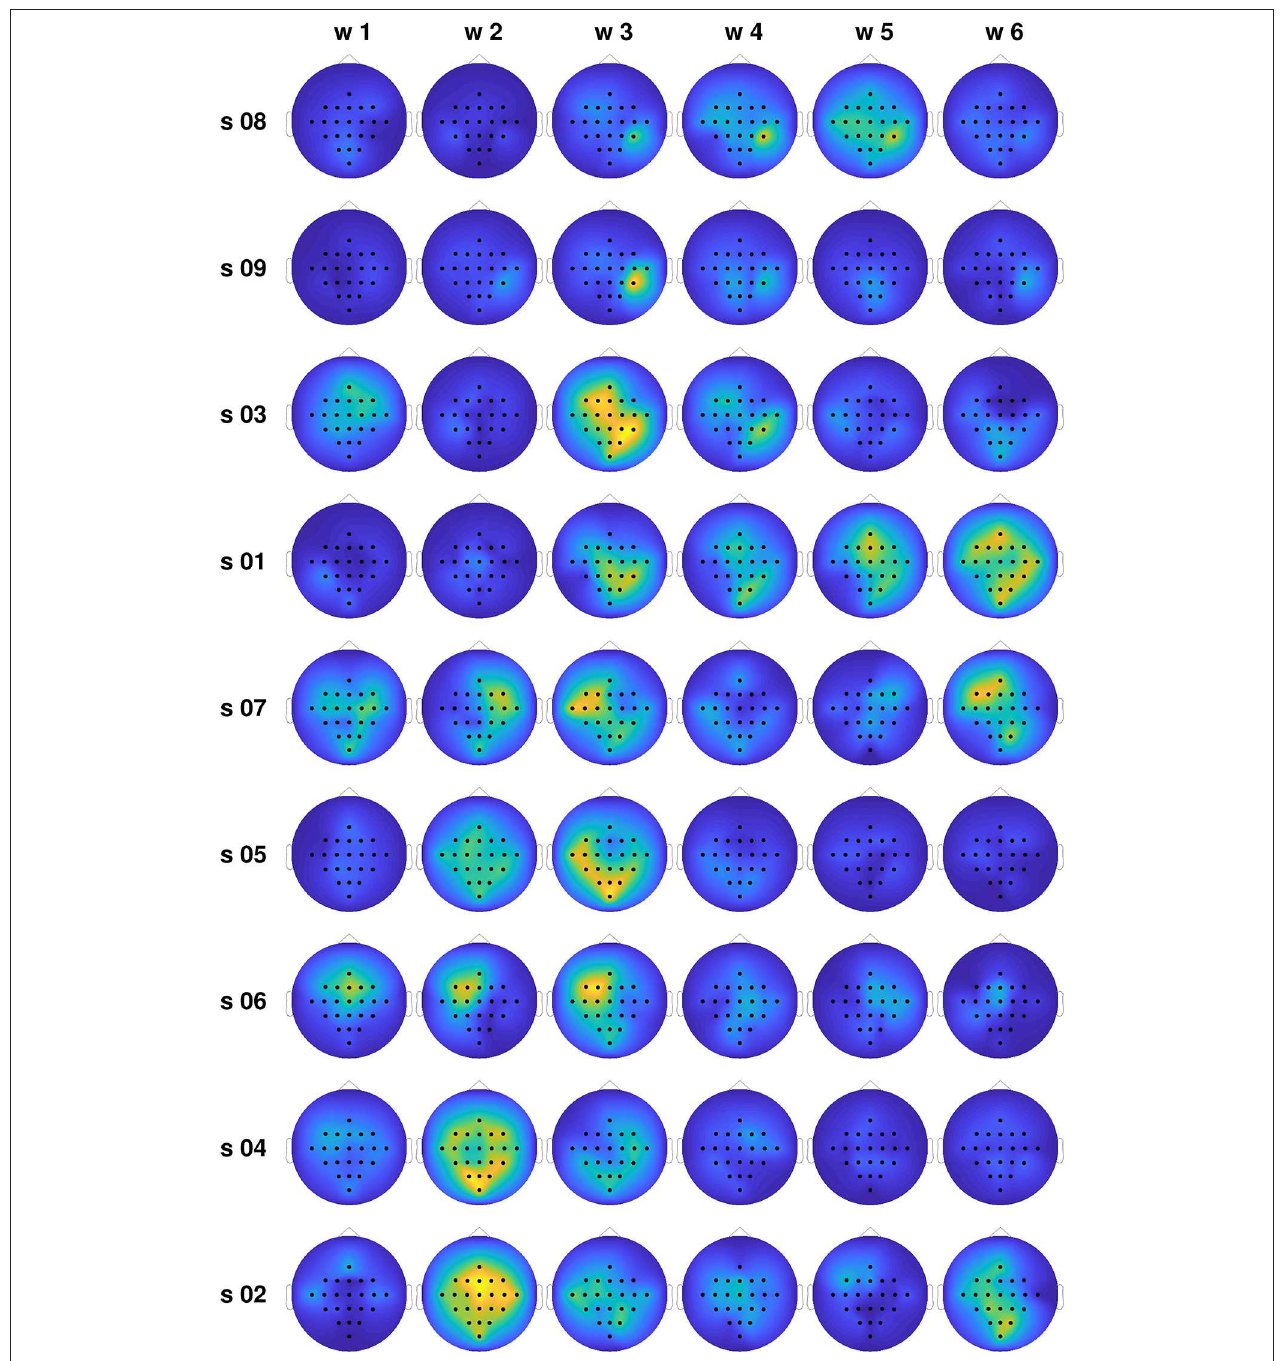
FIGURE 6 | Normalized average differences in the total information flow coming into each channel for the training set, for all subjects and time windows. Large differences are coded in yellow, while small differences are presented in